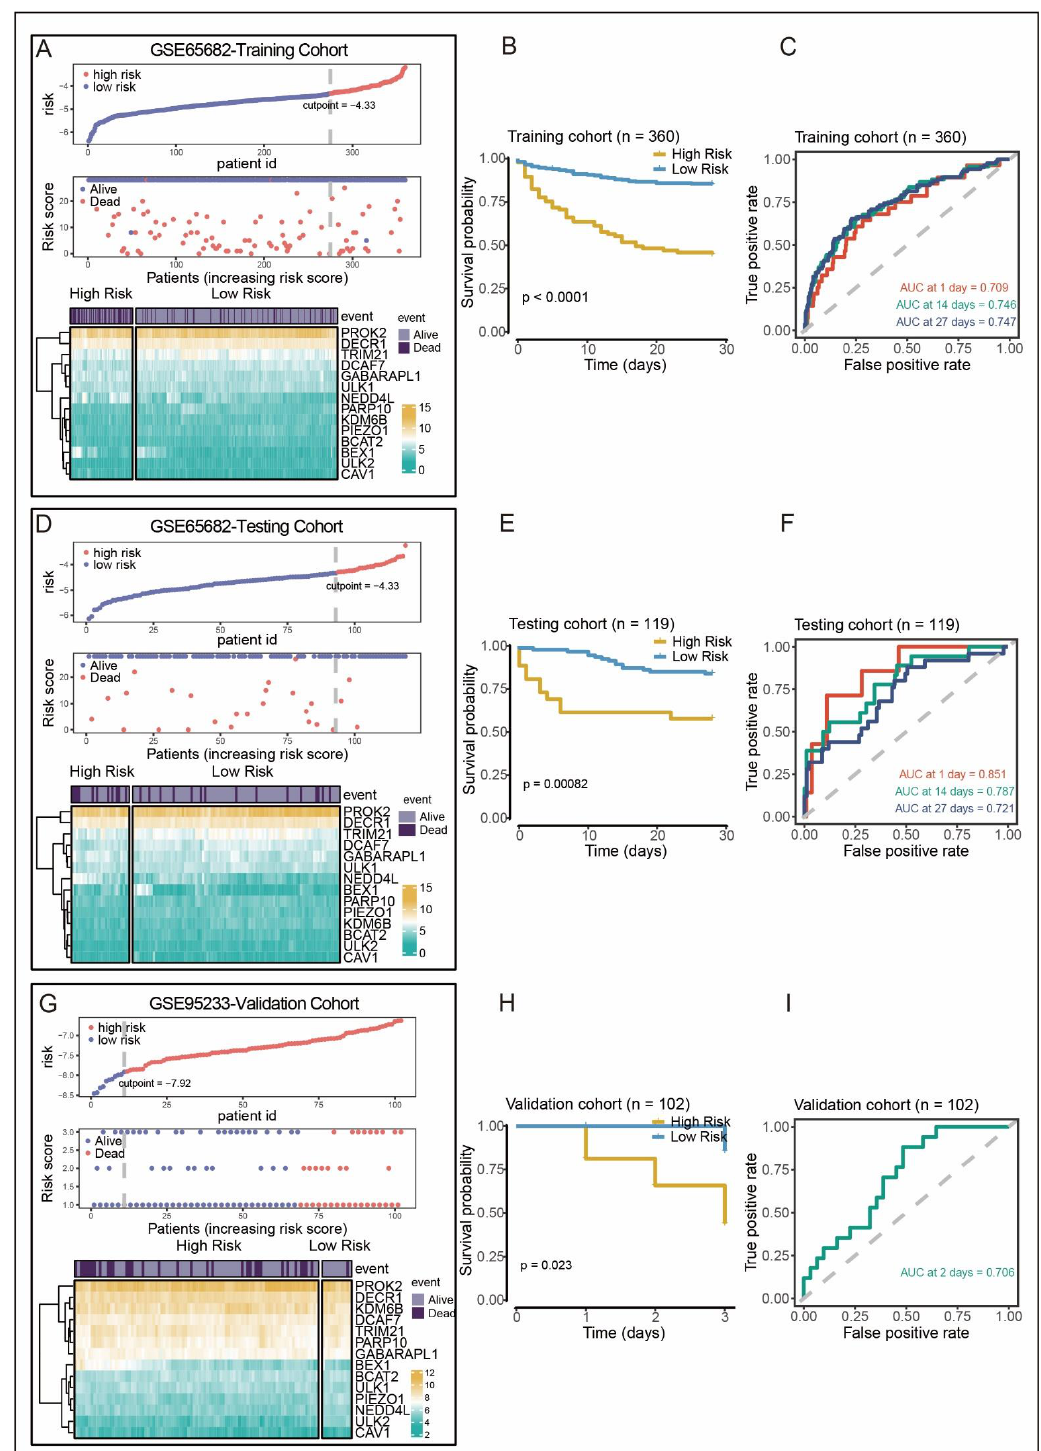
Figure 2. Construction of the risk model in the GSE65682 training cohort and validation of the risk model in the GSE95233 test cohort. ( A , D , G ) Distribution of the risk score, survival status, and gene expression of 14 FAGs in the GSE65682 training cohort ( A ), GSE65682 test cohort ( D ) and GSE95233 cohort ( G ). ( B , E , H ) Kaplan–Meier curves of OS of patients in the high- and low risk groups in the GSE65682 training cohort ( B ), GSE65682 test cohort ( E ) and GSE95233 cohort ( H ). ( C , F , I ) ROC curves for predicting the 1/14-day overall survival in the GSE65682 training cohort ( C ), and ROC curves for prediction the 2-day OS in the GSE95233